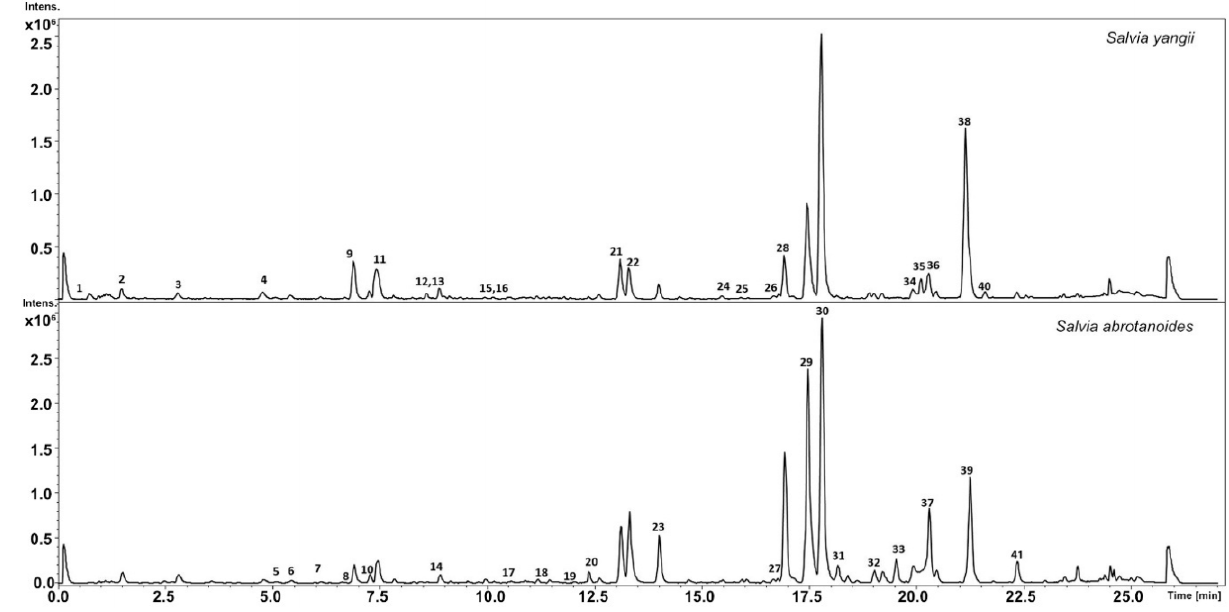
Figure 1. BPC chromatogram of the main metabolites identified in the MeOH extract of leaves of S. yangii and S. abrotanoides , harvested in the middle of the